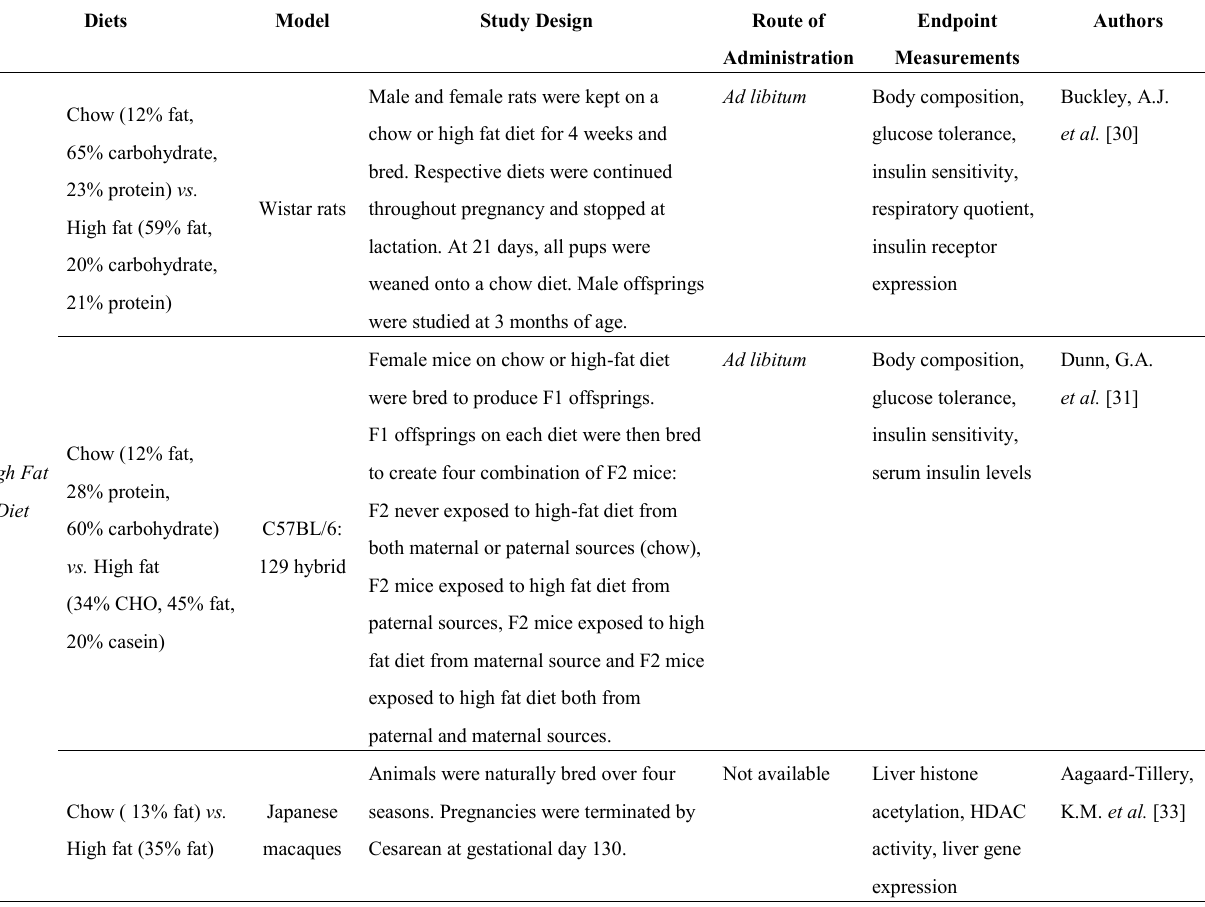
Table 1. Summary of transgenerational mice